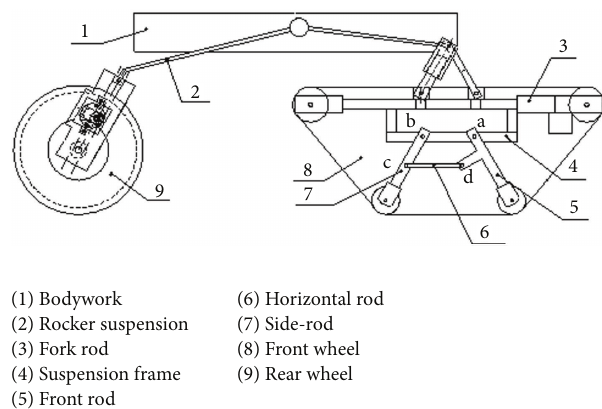
Figure 5: Structure of the planetary wheeled system.